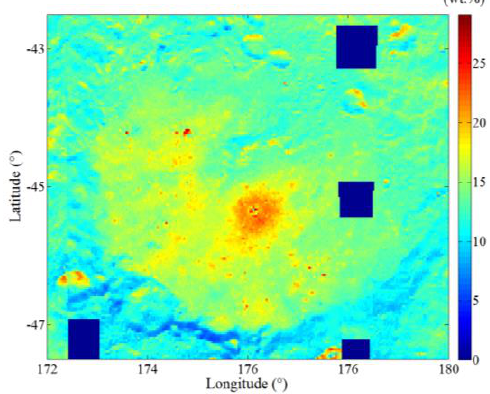
Figure 4 FTA map of Von Kármán crater